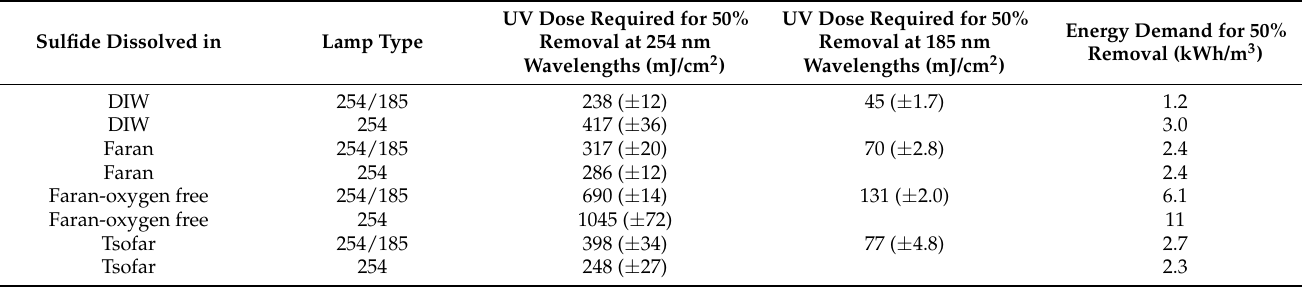
Table 3. The UV dose required for 50% sulfide removal and energy demand for 50% removal in different photodegrada- tion